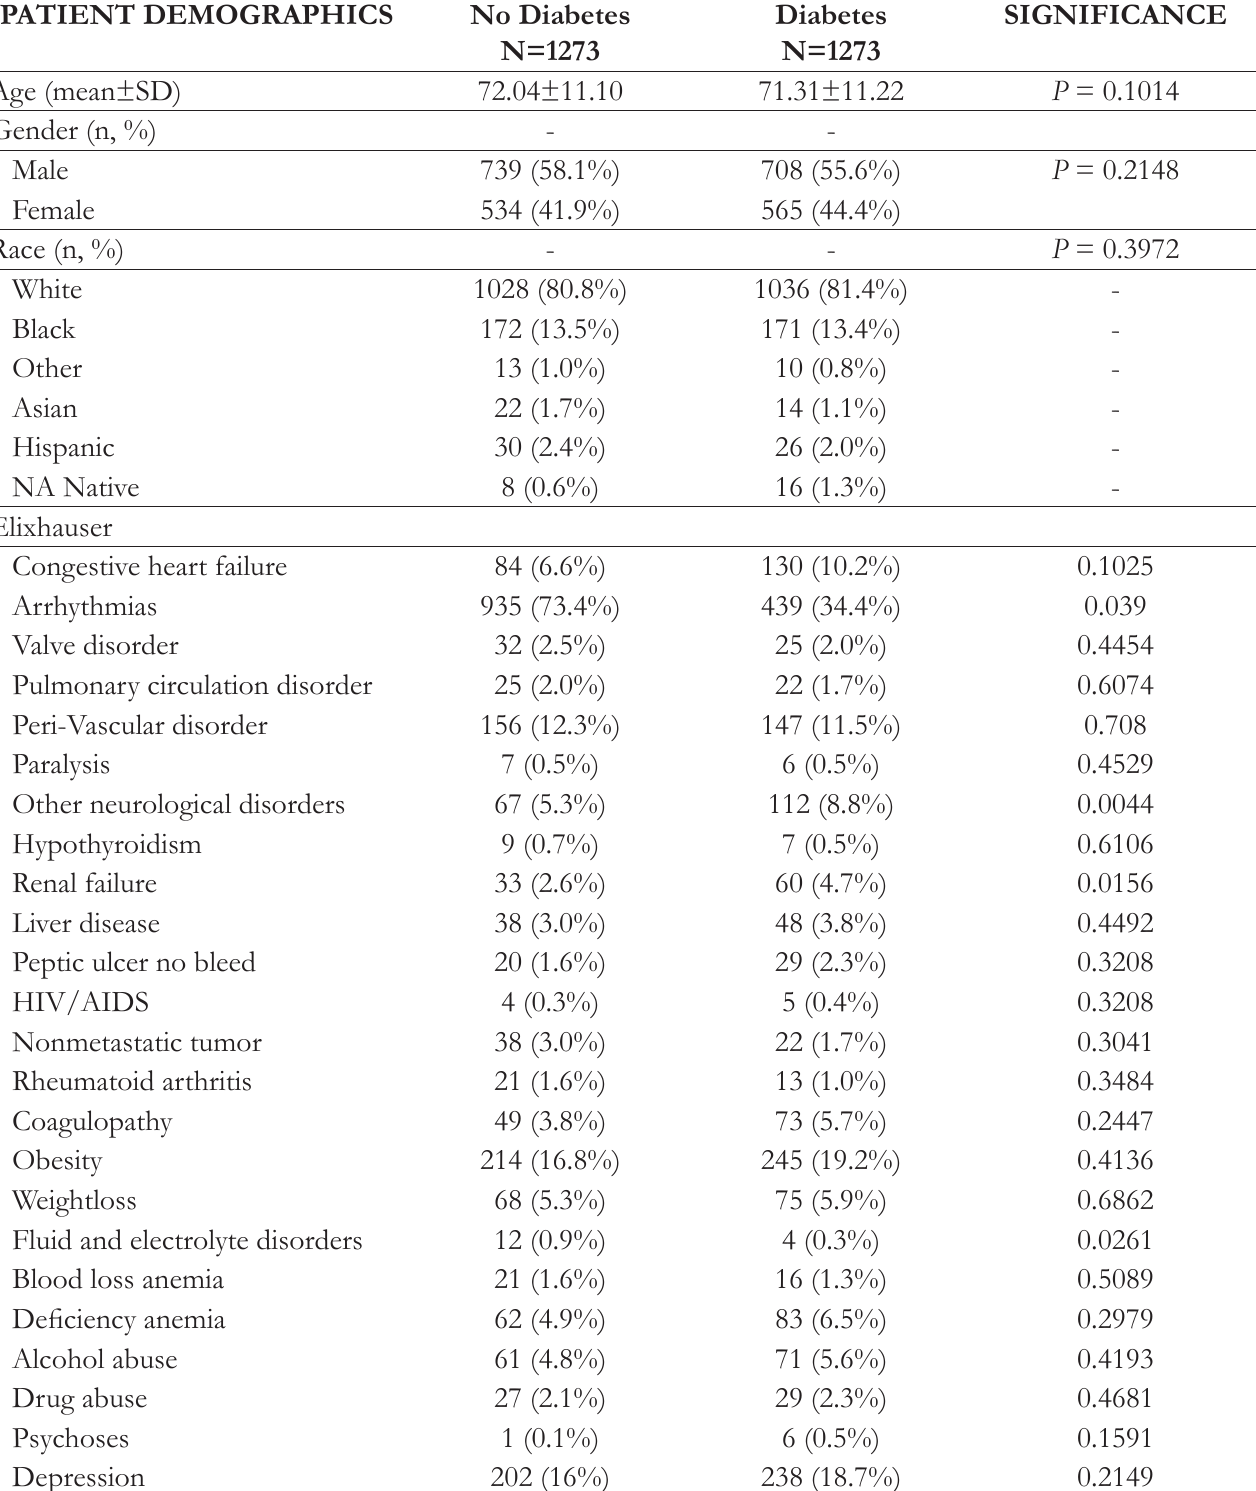
Table 2. Baseline Characteristics after Matching PATIENT